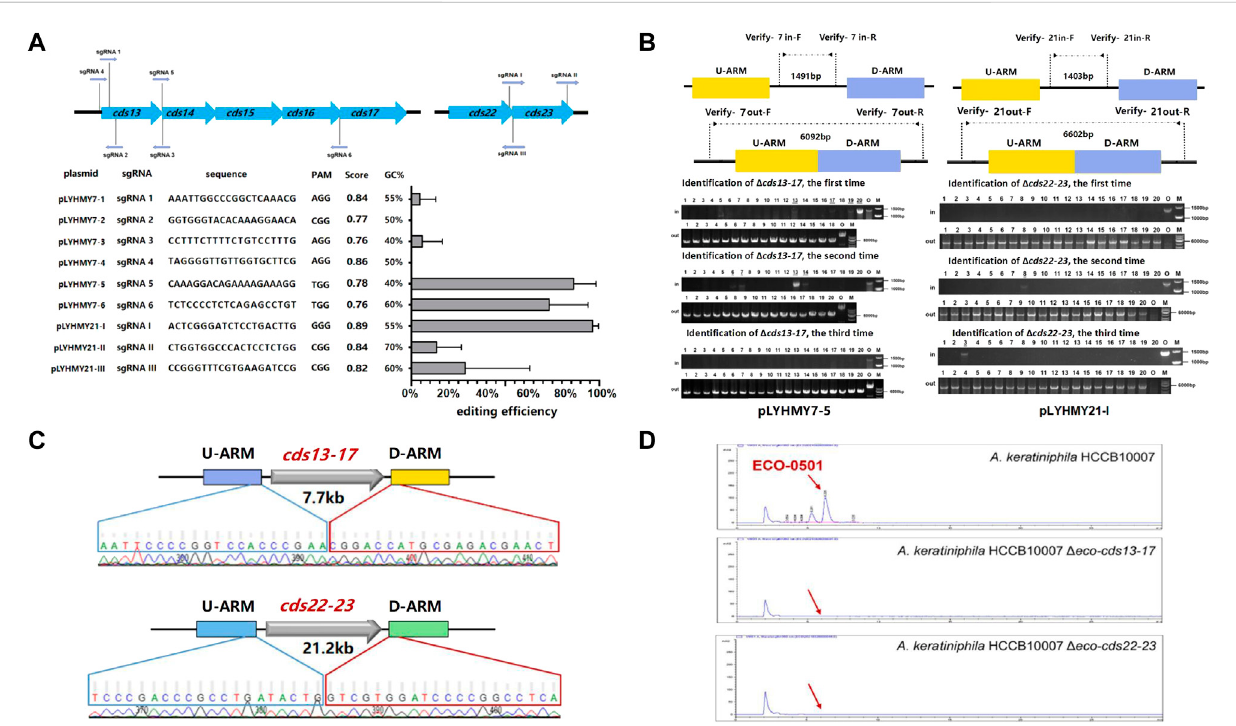
FIGURE 3 CRISPR/Cas9-mediated deletions of large fragments in ECO-0501 BGC. (A) The deletion ef fi ciencies of cds13-17 and cds22-23 obtained by the corresponding editing plasmids. The editing plasmids contained different sgRNAs expression cassettes and up/downstream homologous arms of target clusters. Error bars represented the standard deviations from three independent biological replicates. The information of sgRNAs included the binding position, sequence composition, PAM sequence, score and GC contents. (B) PCR analysis of randomly selected colonies veri fi ed the deletions of cds13-17 and cds22-23 . The amplicons of 1491 bp and 1403 bp were the products of the original strain, respectively, and 6092 bp and 6602 bp amplicons represented that clusters cds13-17 and cds22-23 of colonies were deleted, respectively. The three repeated experiments of pLYHMY7-5 and pLYHMY21-I listed as representative. The underline below the number indicated that the DNA fragments of the colonies had not been deleted after the veri fi cation of Verify-7in-F/Verify-7in-R and Verify-21in-F/Verify-21in-R. M, GeneRuler 1 kb DNA Ladder (Thermo Scienti fi c). O, original strain A. keratiniphila HCCB10007.Lanes 1 – 20, 20colonies transformedbypLYHMY7-5with cds13-17 -speci fi csgRNA5 andpLYHMY21-Iwith cds22-23 -speci fi c sgRNAI. (C) Sanger sequencing results con fi rmed the correct deletion of the cds13-17 and cds22-23 clusters. (D) HPLC detection of ECO-0501 of the